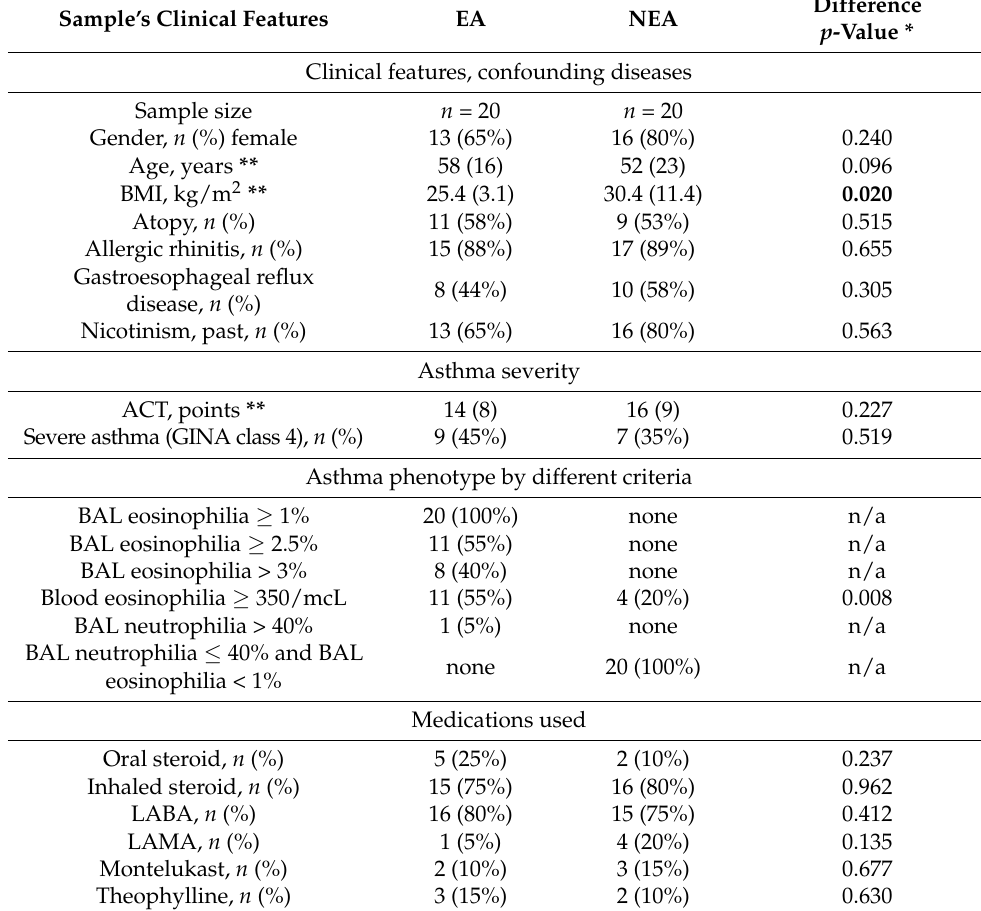
Table 1. Demographic and clinical characteristics of the